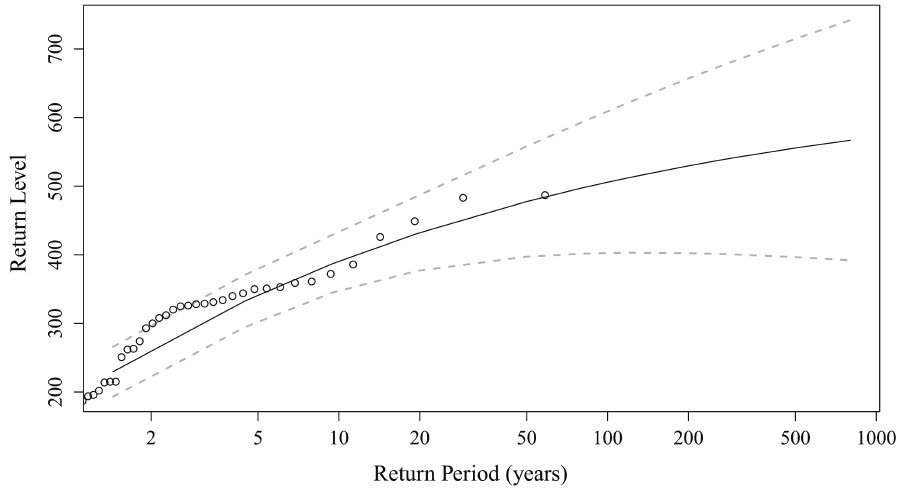
Figure 4. RL plot of the maxima values for daily data with GEV distribution. The dashed lines indicate 95% CIs of the return value, the solid line is the regression line, and the point indicates the RL value for NNN